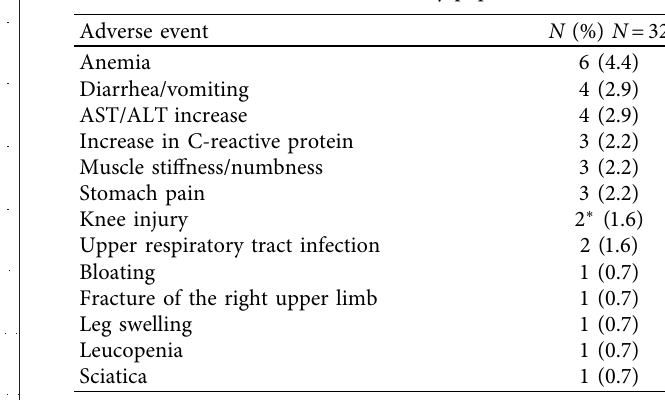
Figure 4: Results of WOMAC questionnaire. Comparison of pain domain, stiffness domain, physical function domain, and total at visit 1, visit 5 (after 12 weeks), visit 9 (after 24 weeks), and visit 13 (after 36 weeks). Results are presented as median with interquartile range Table 2: Adverse events in the safety population ( n � 137).